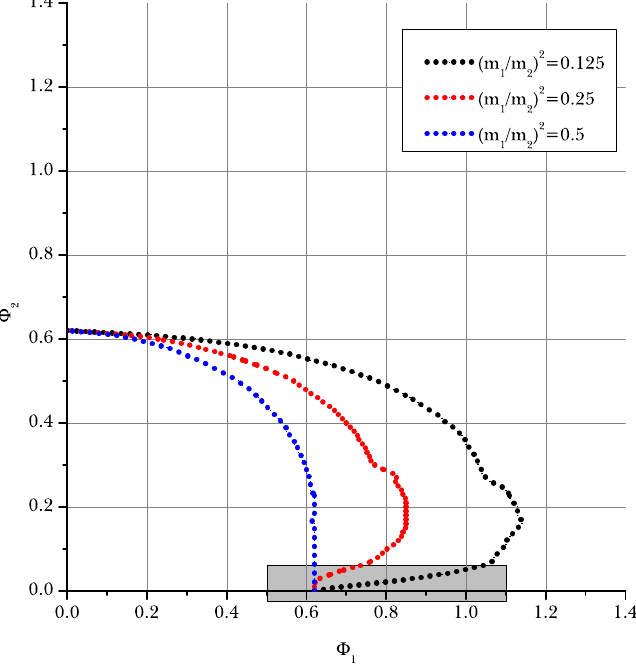
Figure 2. Numerical calculations of the cutoffs for ( m 1 / m 2 ) 2 = 0.125,0.25, and 0.5